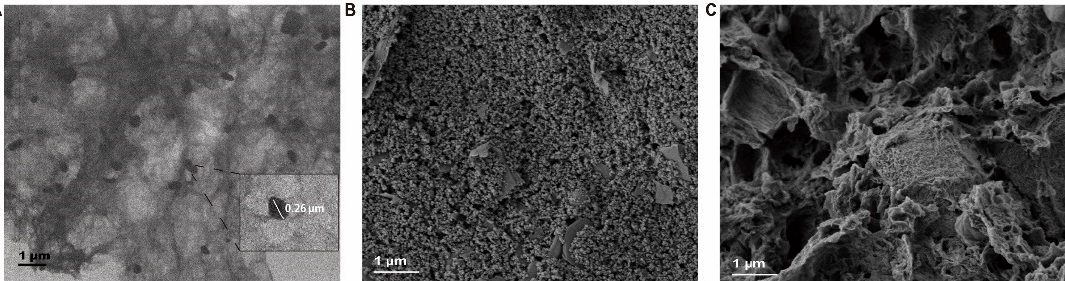
Figure 3. ( A ) TEM images of the prepared of 3D-rGO/AuNPs. SEM images of ( B ) the bare aSPCEs and ( C ) the 3D-rGO/AuNPs-modified aSPCEs.